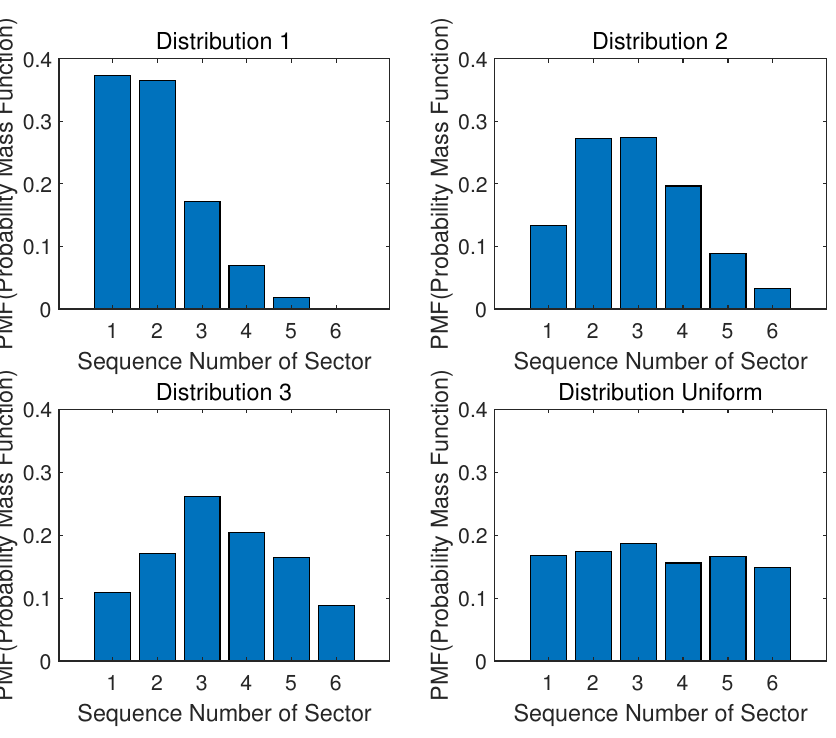
Figure 17. Time for discovery vs. different location.